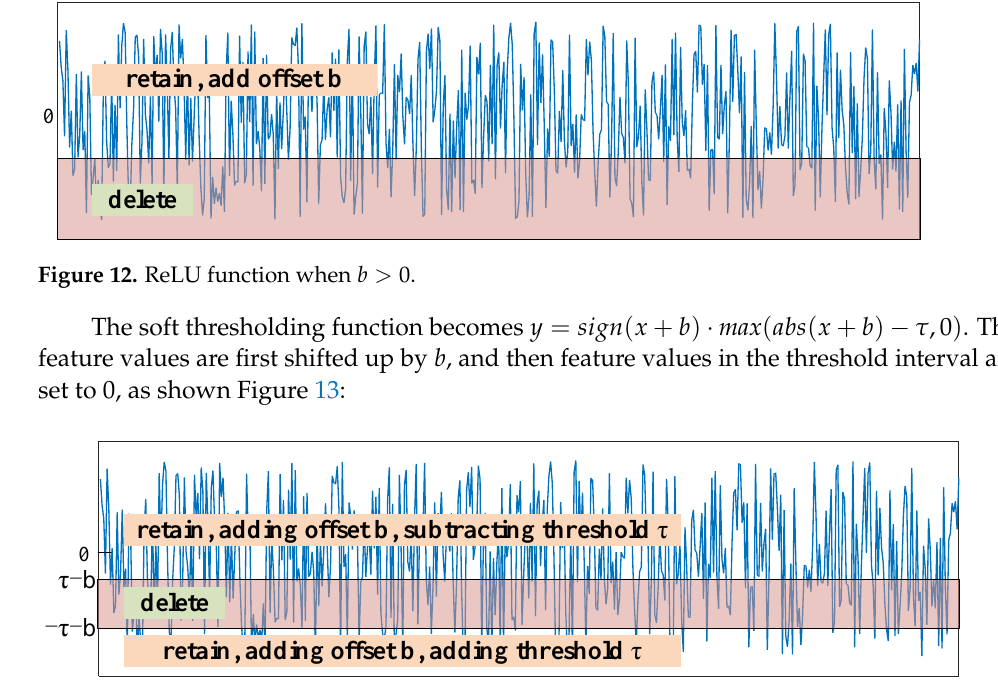
Figure 11. The soft thresholding function when 𝑏 = 0 .